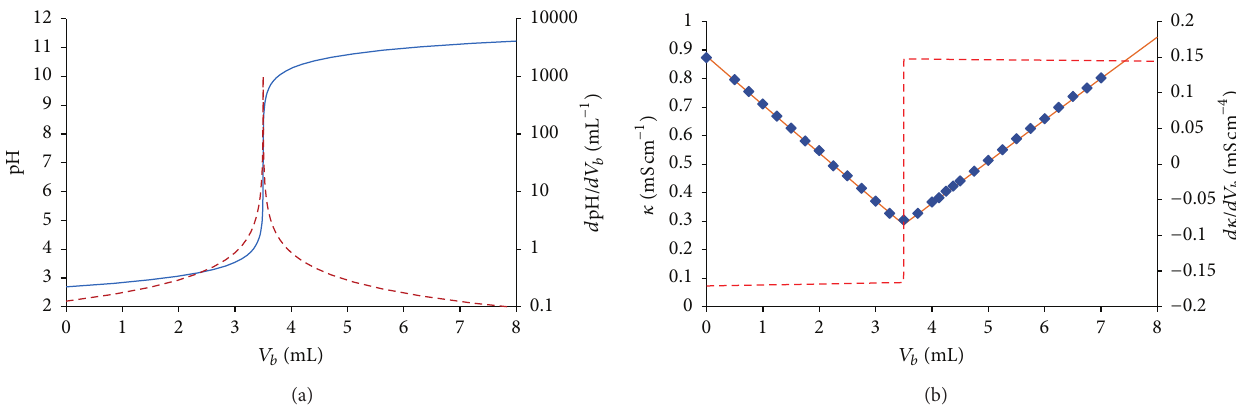
Figure1:Plotsobtainedduringtitrationof20.00 mLH 2 SO 4 0.024 M+430.0 mLdeionizedwaterwithNaOH0.2743 M,at25 ∘ C.(a)pH-metric plots: the solid line represents the plot pH = 𝑓(𝑉 𝑏 ) obtained with (10) while the segmented line represents the plot of 𝑑 pH /𝑑𝑉 𝑏 = 𝑓 󸀠 (𝑉 𝑏 ) ≈ 𝜅 = 𝑔(𝑉 ) . The markers represent the experimental points obtained and the solid line represents the Δ pH /Δ𝑉 𝑏 . (b) Conductometric plot 𝑏 estimated plot with (11); the segmented line represents the plot 𝑑𝜅/𝑑𝑉 𝑏 = 𝑔 󸀠 (𝑉 𝑏 ) ≈ Δ𝜅/Δ𝑉 𝑏 , obtained from the fitted model.